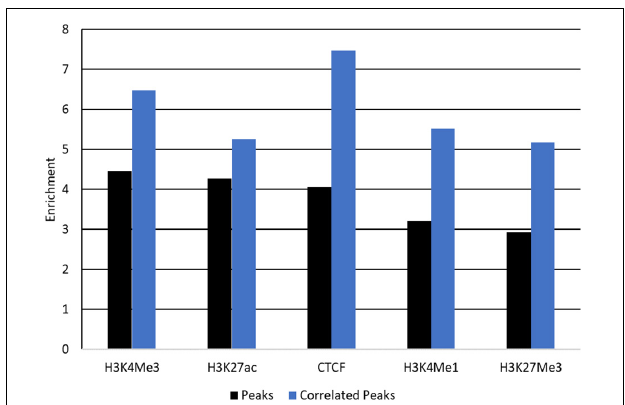
FIGURE 7 | Enrichment of QTL for protein yield in peaks correlated with gene expression. Enrichment of QTL for protein yield within peaks (black) and peaks correlated with gene expression (blue) for each mark. Enrichment was significant with P < 0.001 for all tests.